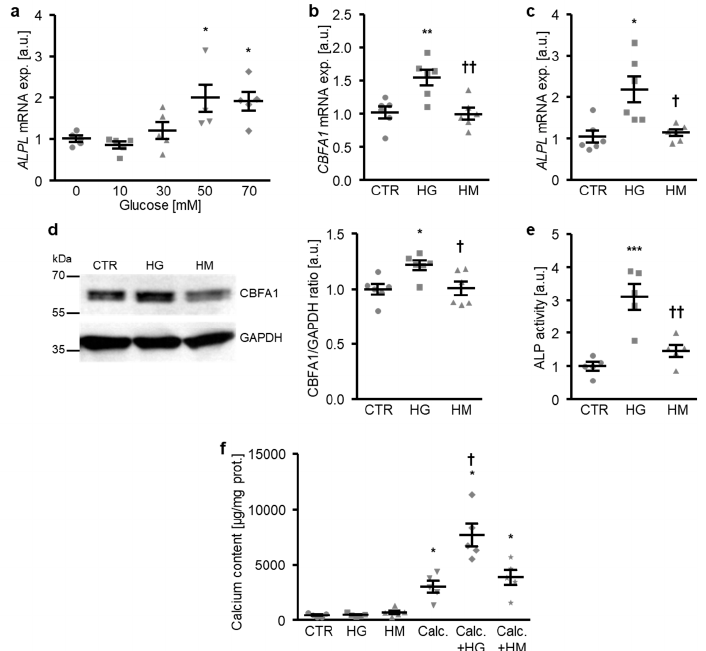
Figure 1. High glucose promotes the osteogenic transdifferentiation and calcification of HAoSMCs. ( a ) Scatter dot plots and arithmetic means ± SEM ( n = 5; arbitrary units, a.u.) of the ALPL relative mRNA expression in HAoSMCs following treatment with the indicated concentrations of glucose (0–70 mM). ( b , c ) Scatter dot plots and arithmetic means ± SEM ( n = 6; a.u.) of the CBFA1 ( b ) and ALPL ( c ) relative mRNA expression in HAoSMCs following treatment with control (CTR), 50 mM of glucose (HG), or 50 mM of mannitol (HM). ( d ) Representative original Western blots and scatter dot plots and arithmetic means ± SEM ( n = 6; a.u.) of the normalized CBFA1 / GAPDH protein ratio in HAoSMCs following treatment with control (CTR), 50 mM of glucose (HG), or 50 mM of mannitol (HM). ( e ) Scatter dot plots and arithmetic means ± SEM ( n = 5, a.u.) of the ALP activity in HAoSMCs following treatment with control (CTR), 50 mM of glucose (HG), or 50 mM of mannitol (HM). * p < 0.05, ** p < 0.01, *** p < 0.001 significant vs. control HAoSMCs; † p < 0.05, †† p < 0.01 significant vs. HG-treated HAoSMCs. ( f ) Scatter dot plots and arithmetic means ± SEM ( n = 5, µ g / mg protein) of the calcium content in HAoSMCs following treatment with control (CTR) or calcification medium (Calc.) without and with 50 mM of glucose (HG) or 50 mM of mannitol (HM). * p < 0.05 significant vs. control HAoSMCs; † p < 0.05 significant vs. Calc.-treated HAoSMCs.